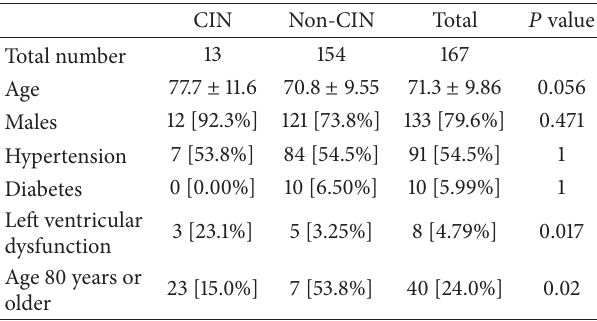
Table 1: Characteristics of patients who underwent endovascular stent graft